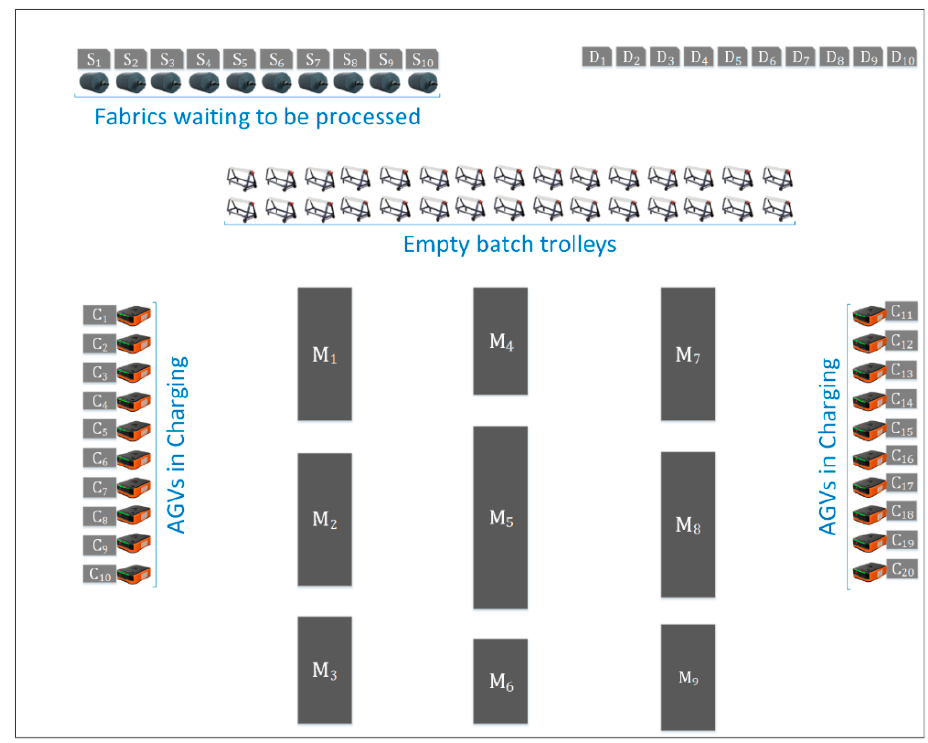
Figure 12. An example simulation map with 10 fabrics, 9 finishing machines, 20 AGVs, and 30 batch trolleys.